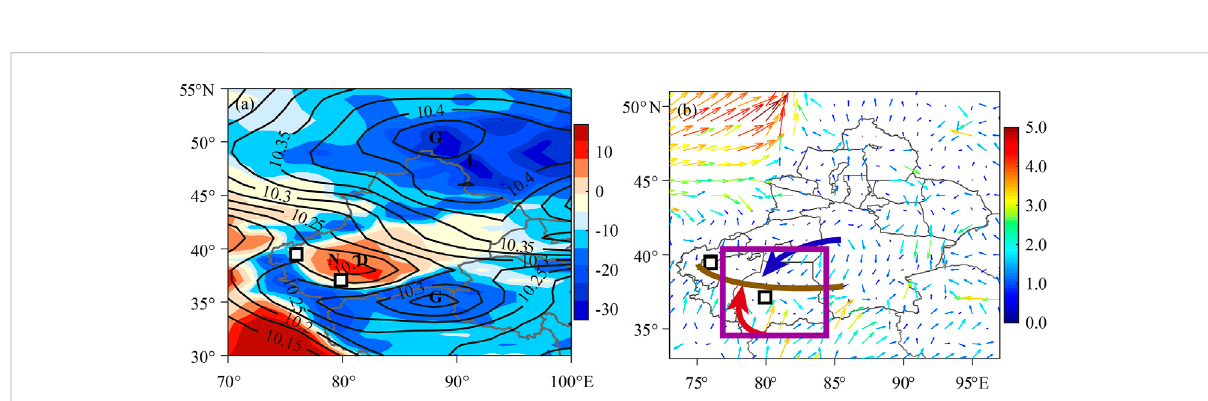
FIGURE 6 (A) Averagesea levelpressure(blackcontour,10 3 Pa) and2-mtemperature (shaded, ° C), and (B) average10-mwind fi eld(coloredvector,m · s − 1 ) inMarchfrom2013to2019. G isthecenterofhighpressure, D isthecenteroflowpressure, L isthecenterofcoldairand N isthecenterofwarmair. Brown thick line, blue and red vector indicate the location of surface convergence line, northerly wind and southerly wind, respectively. White squares indicate the monitoring stations in region Ⅳ